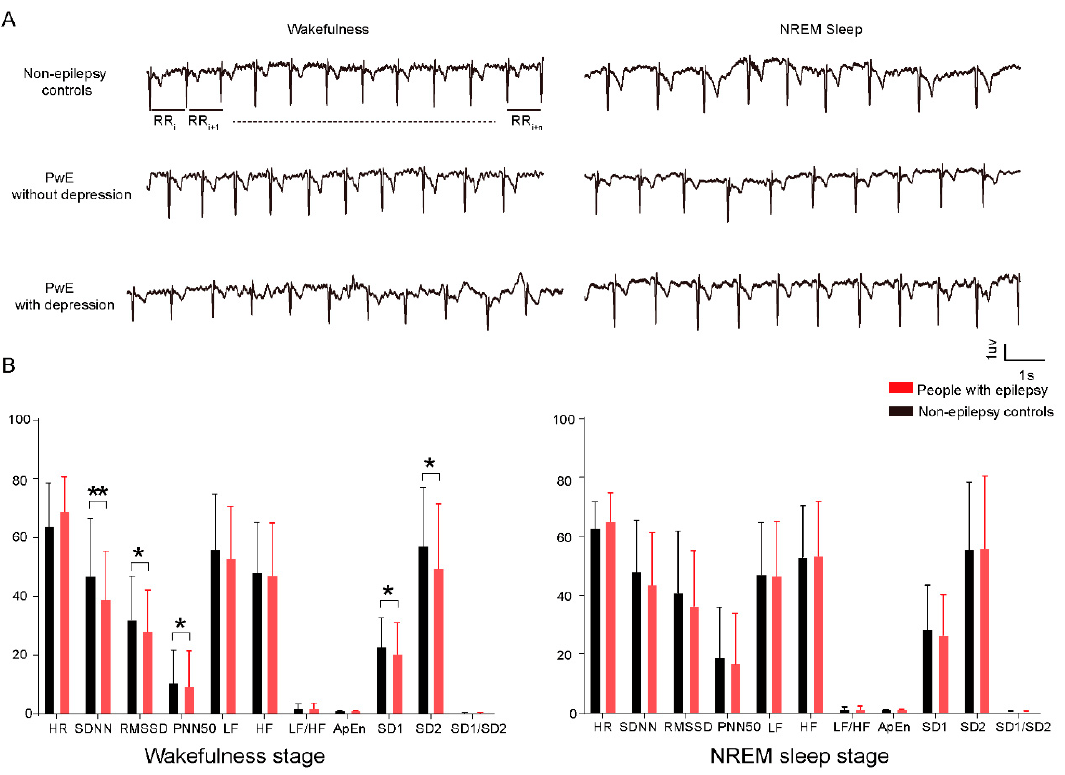
Figure 2. Significant differences in HRV parameters have been observed between people with epi- lepsy (PwE) and non-epilepsy controls. ( A ) Representative electrocardiography RR intervals in non- epilepsy controls and PwE with and without depression. ( B ) In comparison with the non-epilepsy controls, PwE exhibited a lower time domain and nonlinear domain indexes in wakefulness stage (Mann–Whitney test, SDNN p = 0.006, RMSSD p = 0.0449, PNN50 p = 0.0332, SD1 p = 0.0453, SD2 p = 0.0167); no significance differences have been observed in NREM sleep stage. * p < 0.05, ** p < 0.001. Concepts of HRV parameters in the figure have been explained in detail in Section 2.